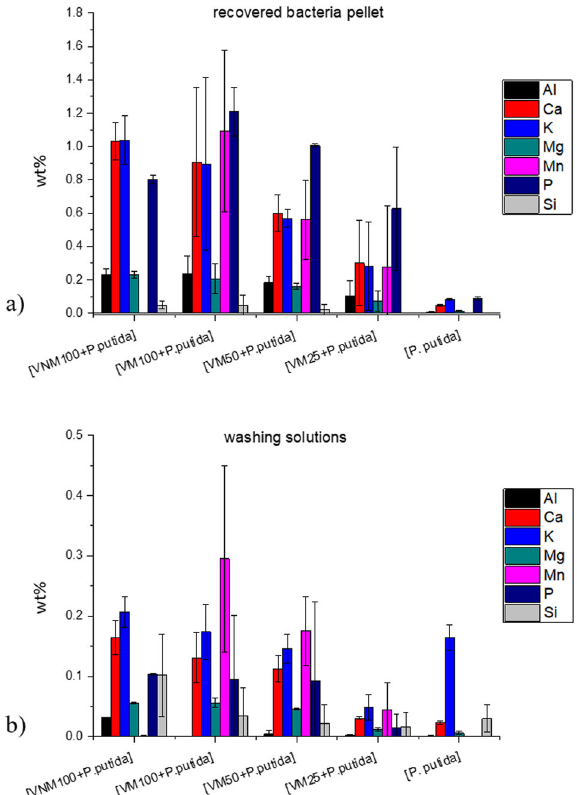
Fig. 6 Mass percentages. a Dry bacterial pellets, b Washing solutions recovered at the end of the experiments. Uncertainty bars correspond to the uncertainties calculated taking into account the analytical ICP-OES error (10%), and, when available, the standard deviation for the